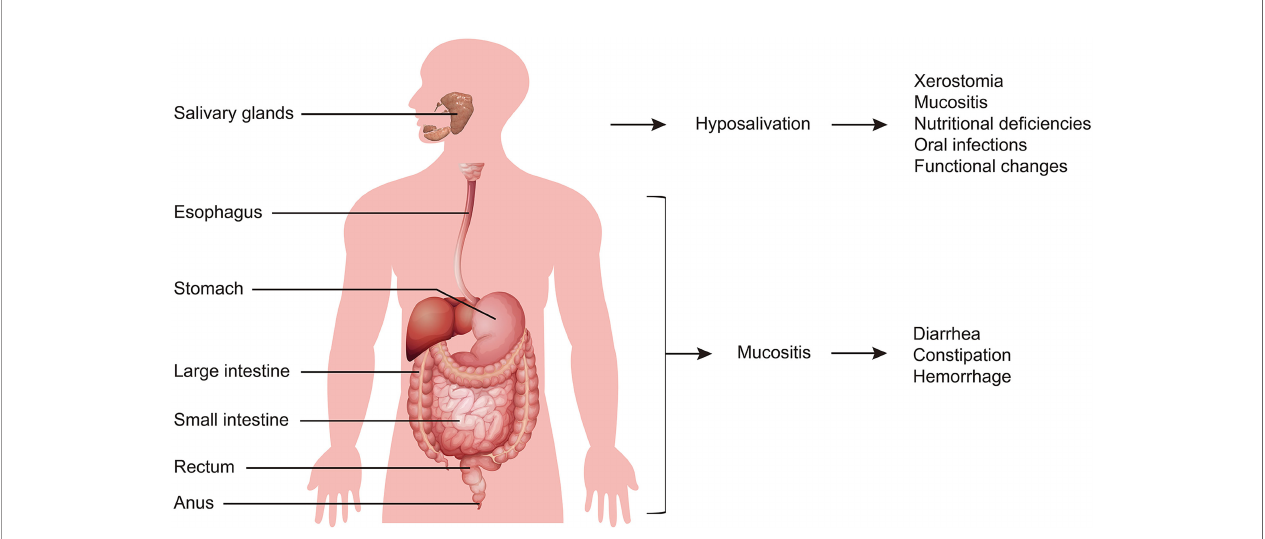
FIGURE 2 | General symptoms of radiation-induced digestive injury. Salivary gland injury is initiated from hyposalivation, and is followed by xerostomia, mucositis, nutritional de fi ciencies, oral infections, and functional changes. Digestive tract injury starts with mucous in fl ammation, and then exhibits diarrhea, constipation, and